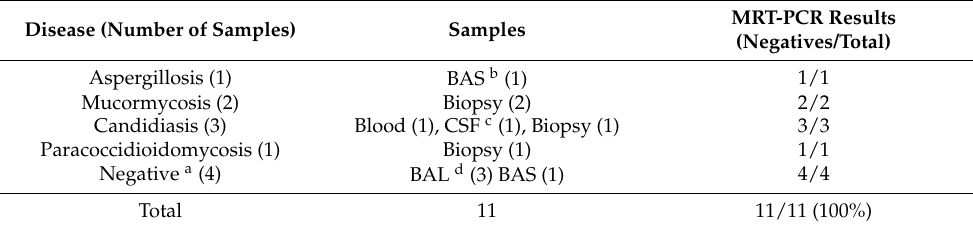
Table 4. MRT-PCR (multiplex real-time PCR) results for control samples. Disease (Number of Samples)